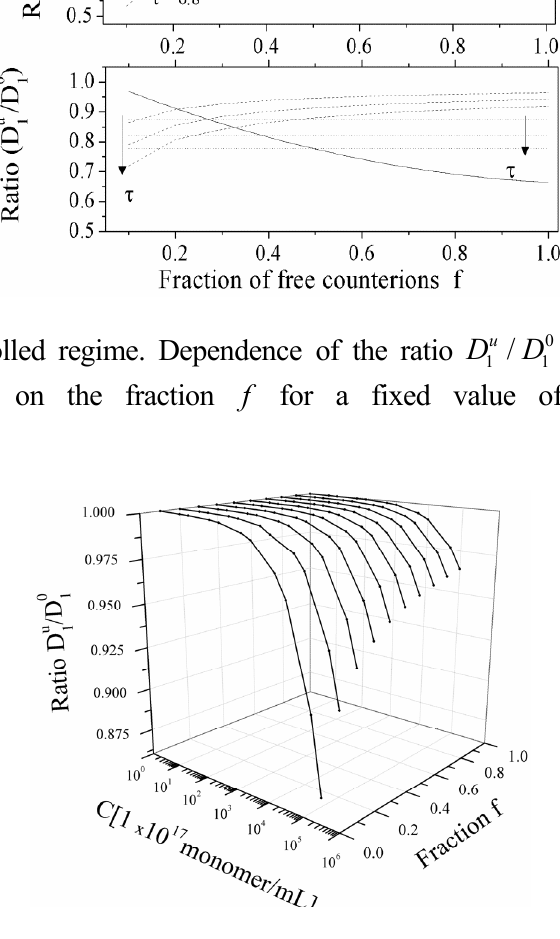
/ u D D for polyelectrolytes solution in dilute regime; Figure 3. (Upper panel): the ratio 0 1 1 full line: good solvent condition; dotted lines: poor solvent condition, with four different / u D D for values of the parameter τ ( τ = 0.2, 0.4, 0.6, 0.8). (Bottom panel): the ratio 0 1 1 polyelectrolytes solution in semidilute regime. Full line: good solvent condition. Dotted lines: poor solvent condition, in string-controlled regime. Dashed lines: poor solvent condition, in bead-controlled regime with different values of the parameter τ ( τ = 0.4, 0.6, 0.8, in the order marked by the arrow).